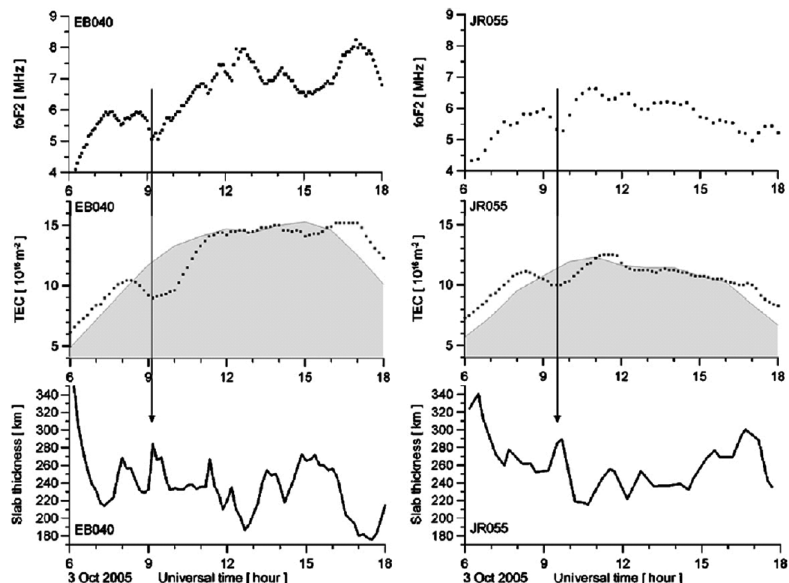
Fig. 3. Variations of the ionospheric slab-thickness over the Ebro, Spain (left) and Juliusruh, Germany (right) stations during the solar eclipse on 3 October 2005. After Jakowski et al.